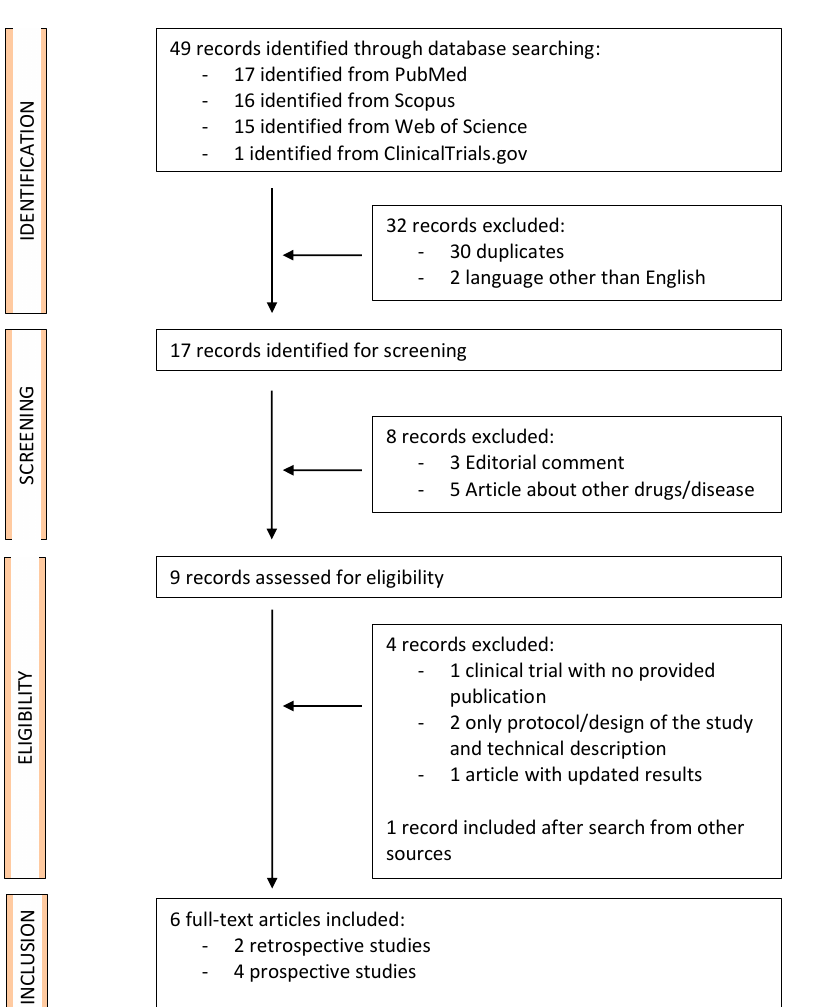
Figure 1. PRISMA (Preferred Reporting Items for Systematic Review and Meta-Analyses) flow diagram for identification and selection of studies assessing the efficacy of transperineal laser ablation (TPLA) for benign prostatic enlargement (BPE).